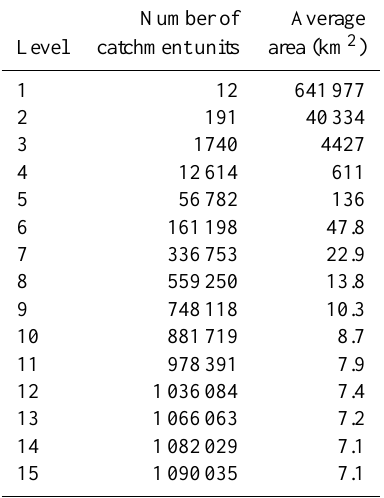
Table 2. Number and average area of catchment units at each level in the nested